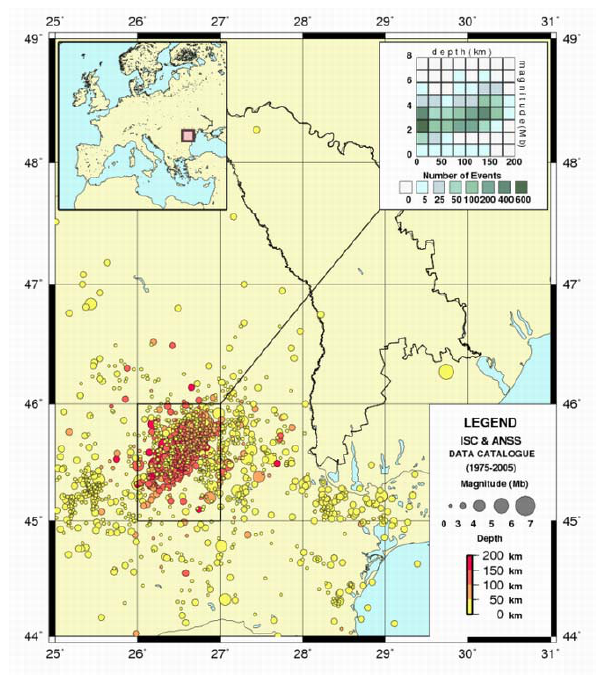
Figure 1. Vrancea zone